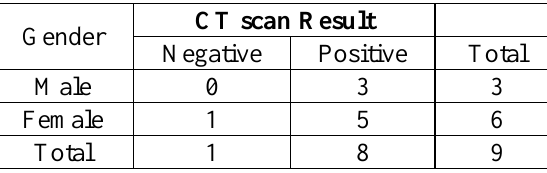
Table 6 : A comparative of validity of radiograph (cross – over sign) and CT scan tests